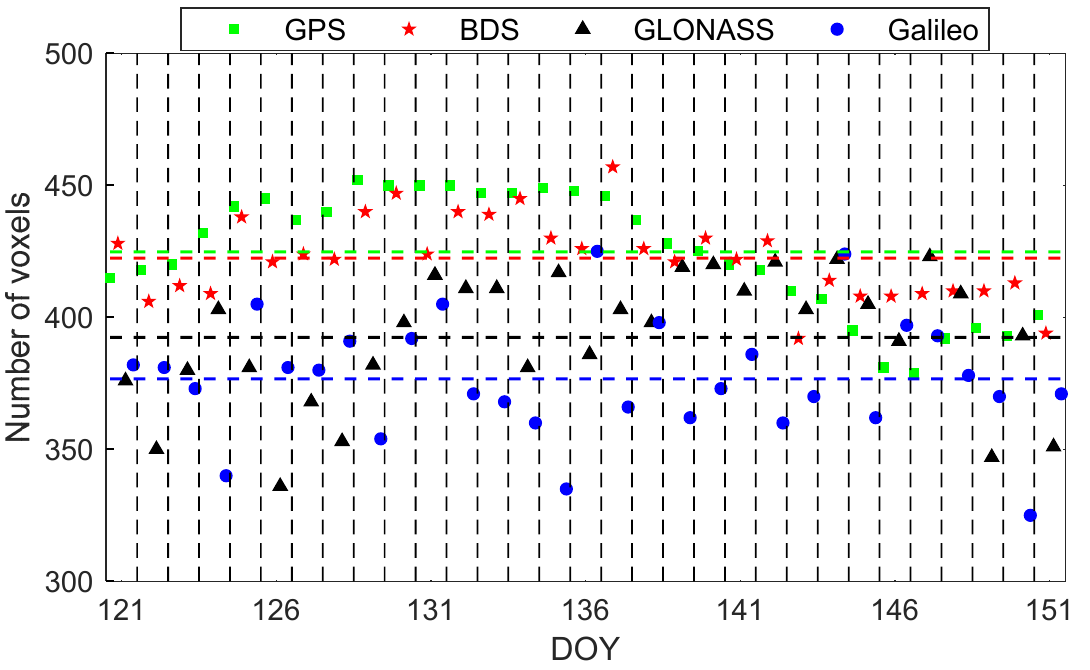
Figure 3. Average number of voxels penetrated by signal rays in each solution based on different satellite systems during the experimental period.